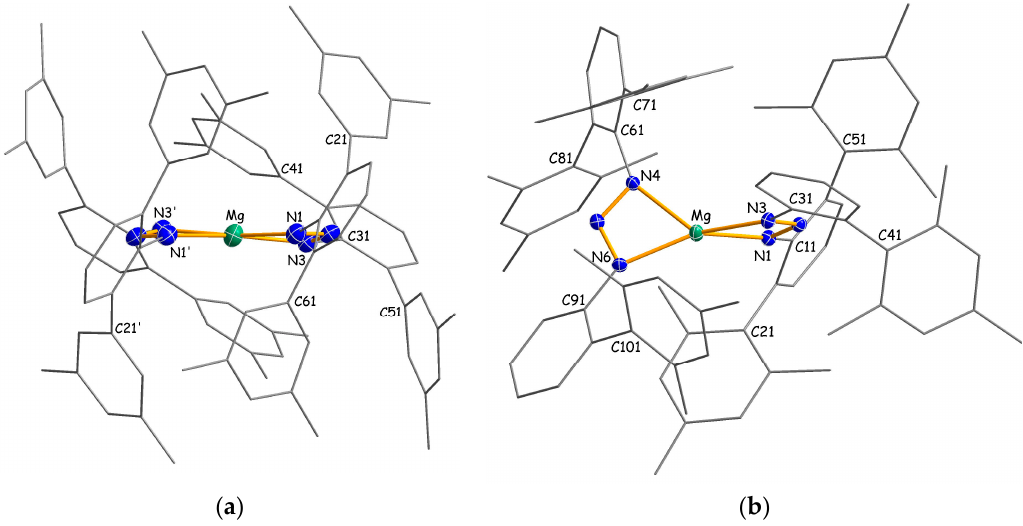
Figure 3. Molecular structures of 4b ( a ) and 4c ( b ) with thermal ellipsoids set to 30% probability. Hydrogen atoms and co-crystallized solvents have been omitted and carbon atoms are reduced in size for clarity. Selected bond lengths (Å), angles and dihedral angles (°) for 4b (symmetry operation ( (cid:48) ): − x + 1/2, y , − z + 1/2): Mg–N1 = 2.131(2), Mg–N3 = 2.125(2), Mg–N2 =